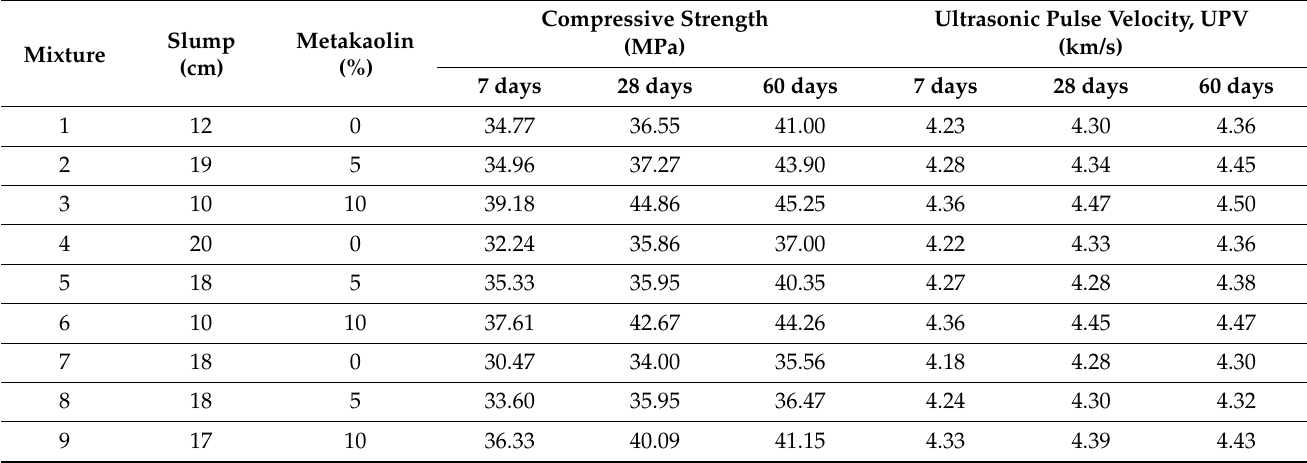
Table 3. Experimental average results for the compressive strength and ultrasonic pulse velocities (UPVs) of each mixture tested for hardened concrete